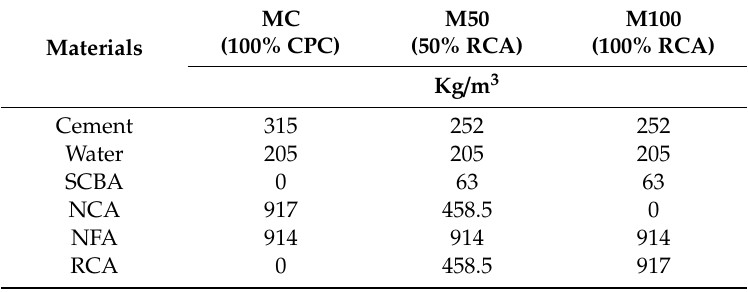
Table 2. Proportioning of concrete mixtures in kg for 1 m 3 of concrete ( f (cid:48) c = 22.5 MPa).